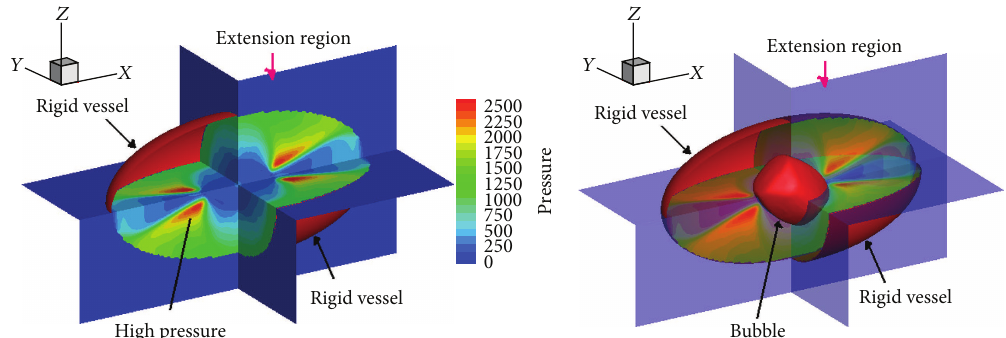
Figure 17: Numerical results by GFM-based algorithm 𝑡 = 0.487 ms. Left: pressure cloud pictures, right: bubble shape (Case 6).